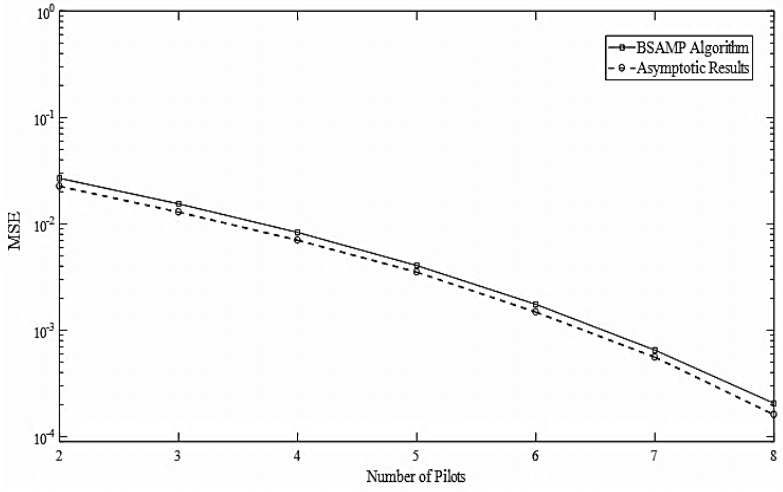
Figure 6. Comparison of MSE for the proposed BSAMP algorithm under a different number of pilots.